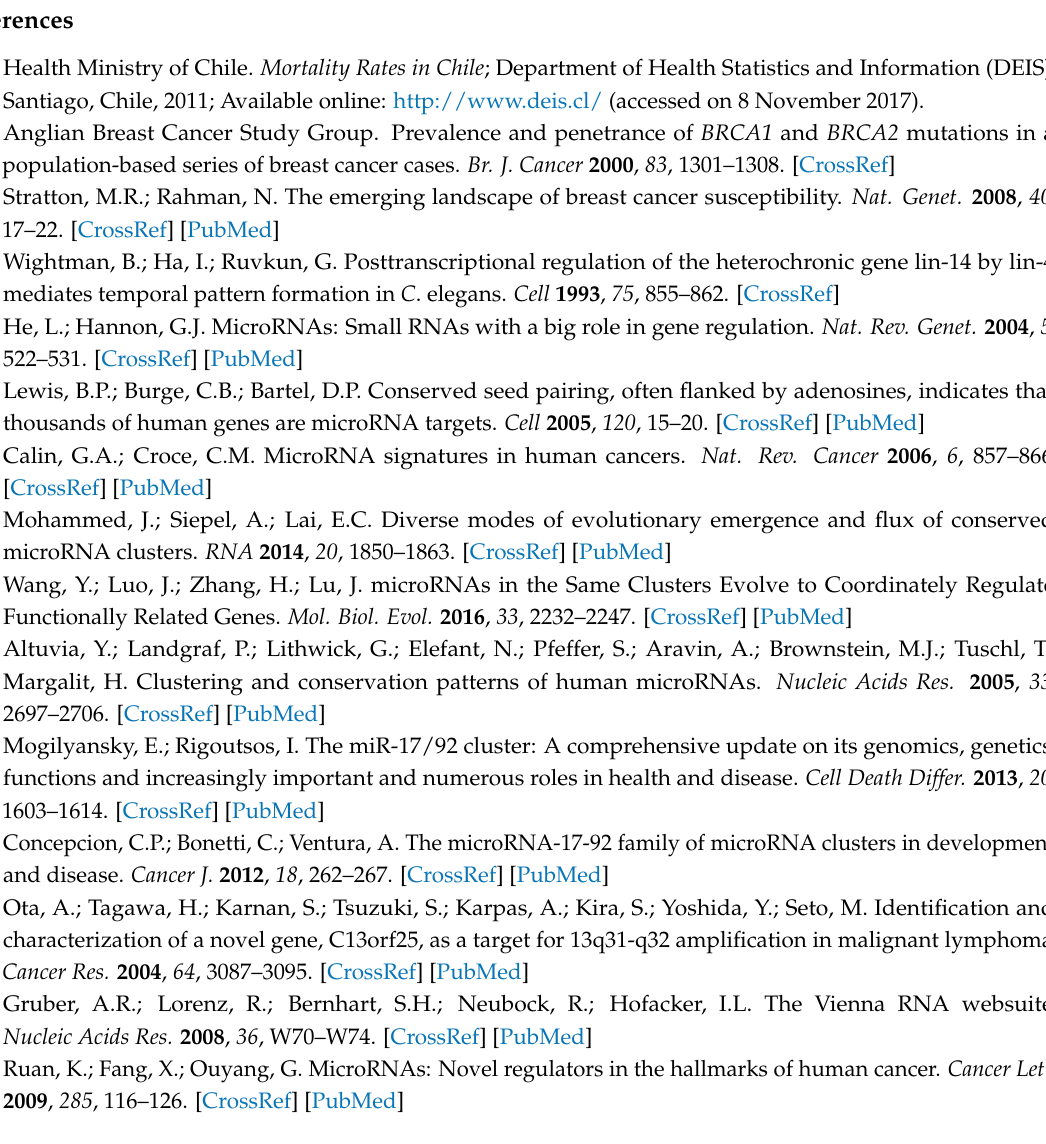
Figure A2. Pedigree of the affected family. Arrows indicate both the proband and her daughter. Roman numbers = Generations.